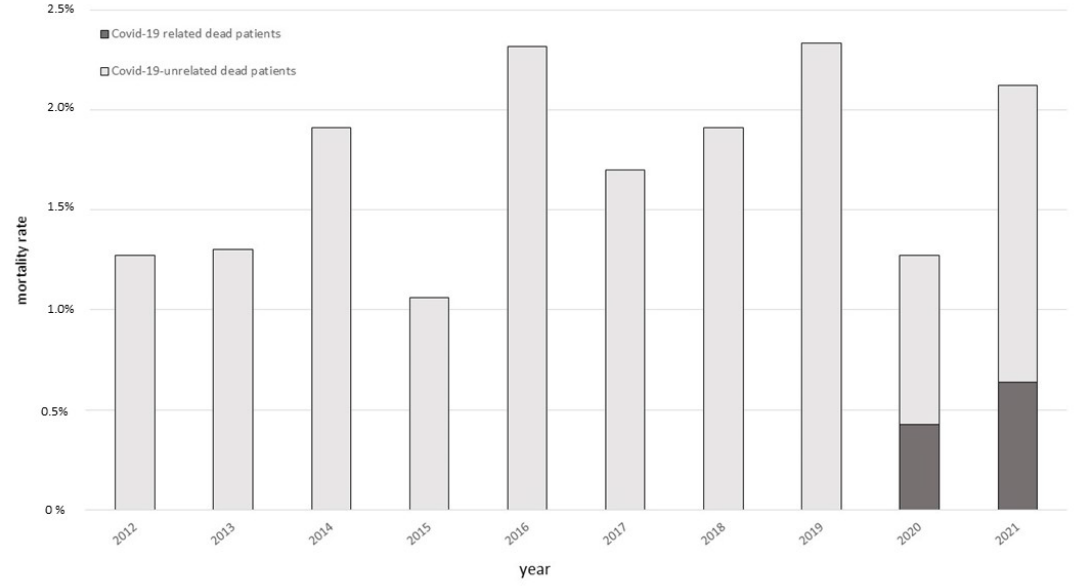
Figure 2. Annual mortality in the cohort of IEI patients with Primary Antibody Deficiencies in the period 2012–2021. Dead patients for COVID-19-related causes are indicated in gray; dead patients for COVID-19-unrelated causes are indicated in black.